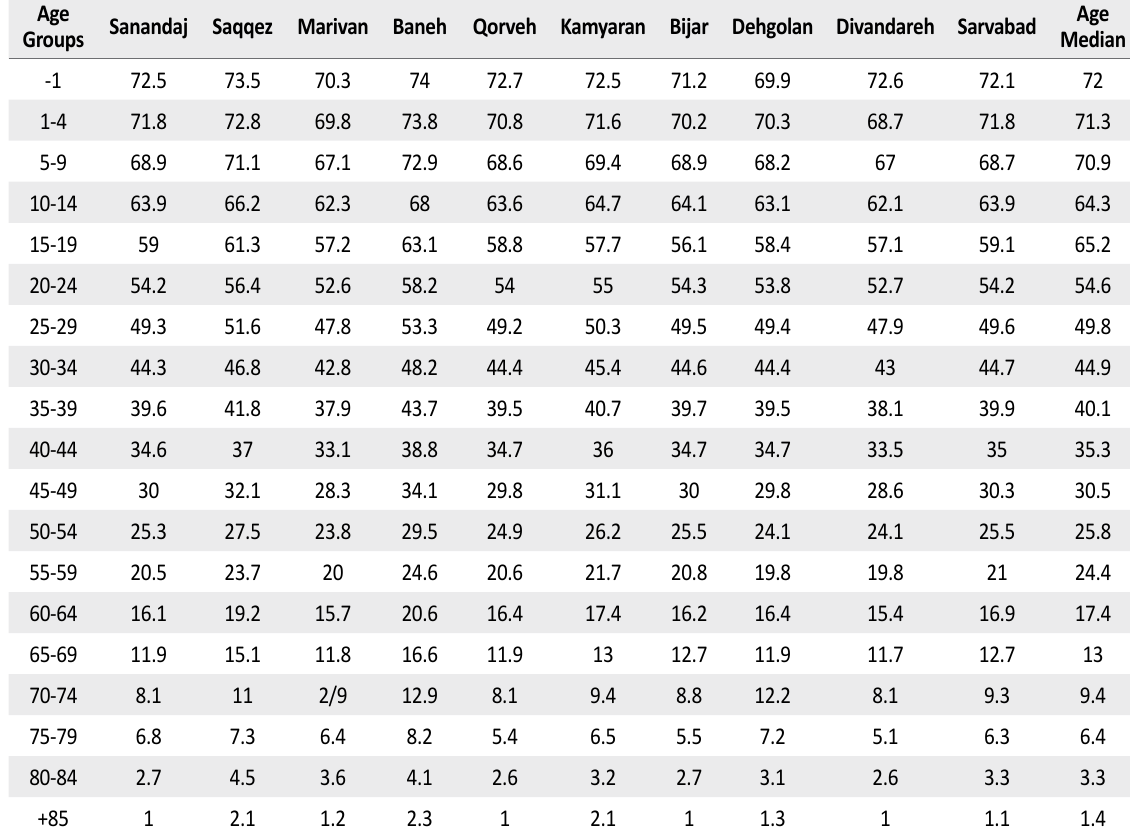
Table 2. Life expectancy at birth (y) for females in 10 towns of Kurdistan Province, 2013 Age Sanandaj Saqqez Marivan Groups